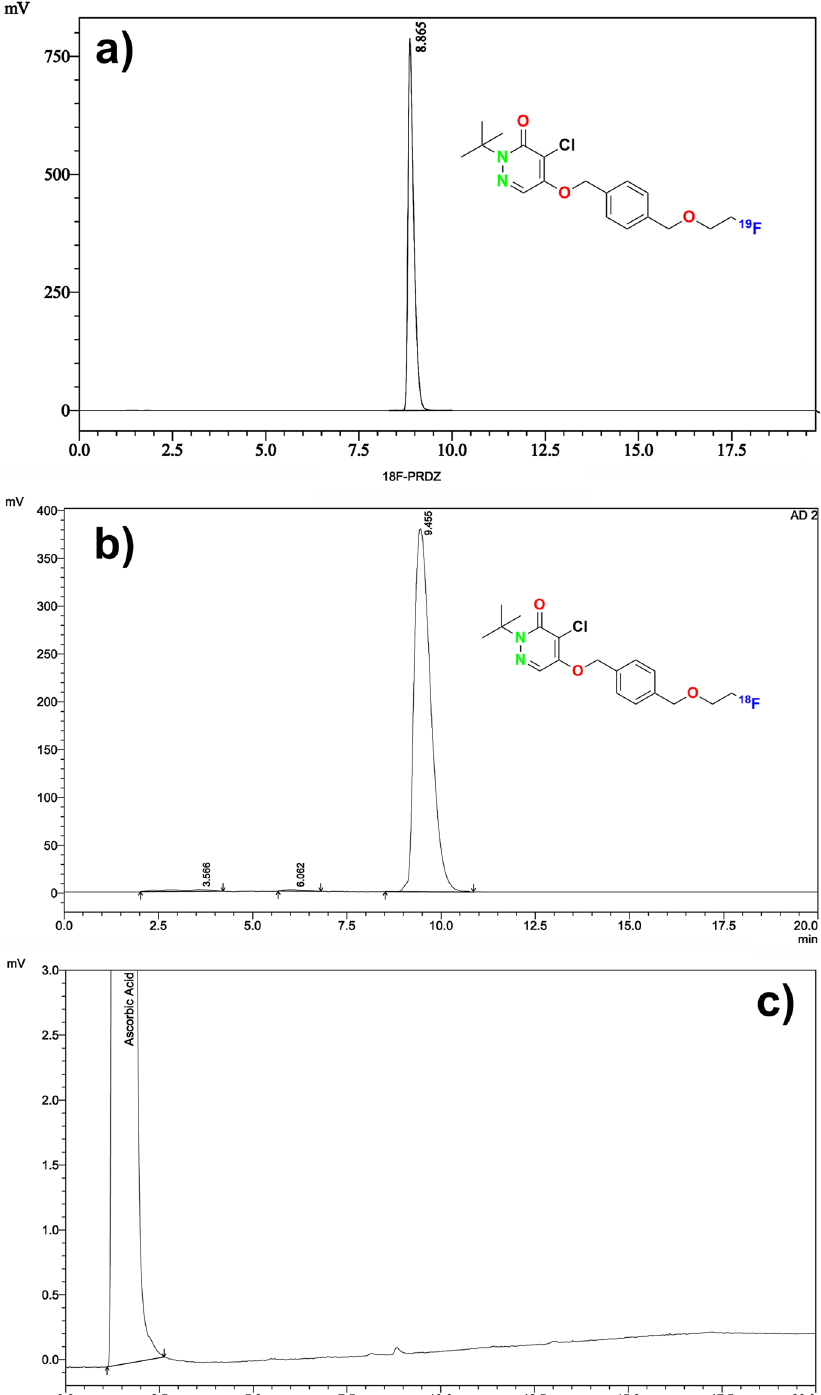
Fig. 6 Radio-HPLC chromatogram and identification of [ 18 F]Flurpiridaz ( 7 ) ( b ), HPLC–UV chromatogram of [ 18 F]Flurpiridaz ( 7 ) ( c ), HPLC–UV chromatogram of [ 19 F]Flurpiridaz ( a ) ( 7